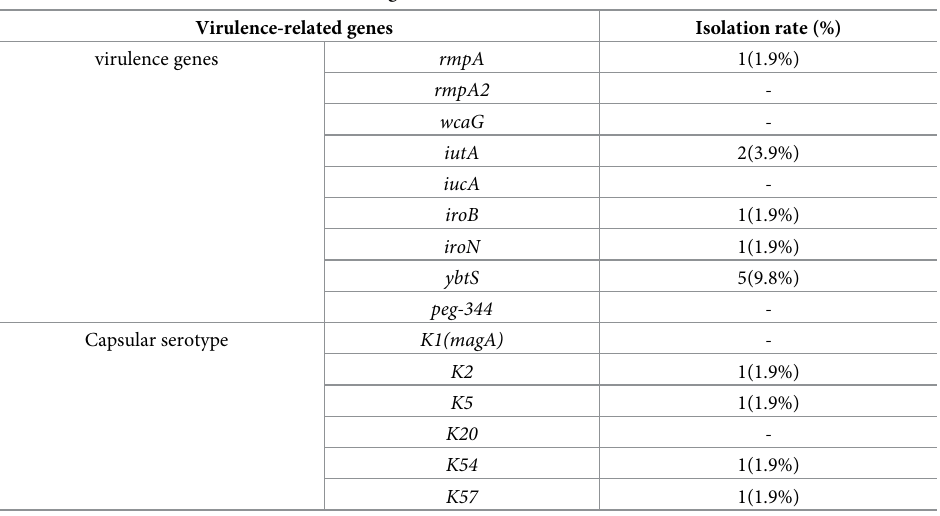
Table 5. The isolation rate of virulence-related genes.